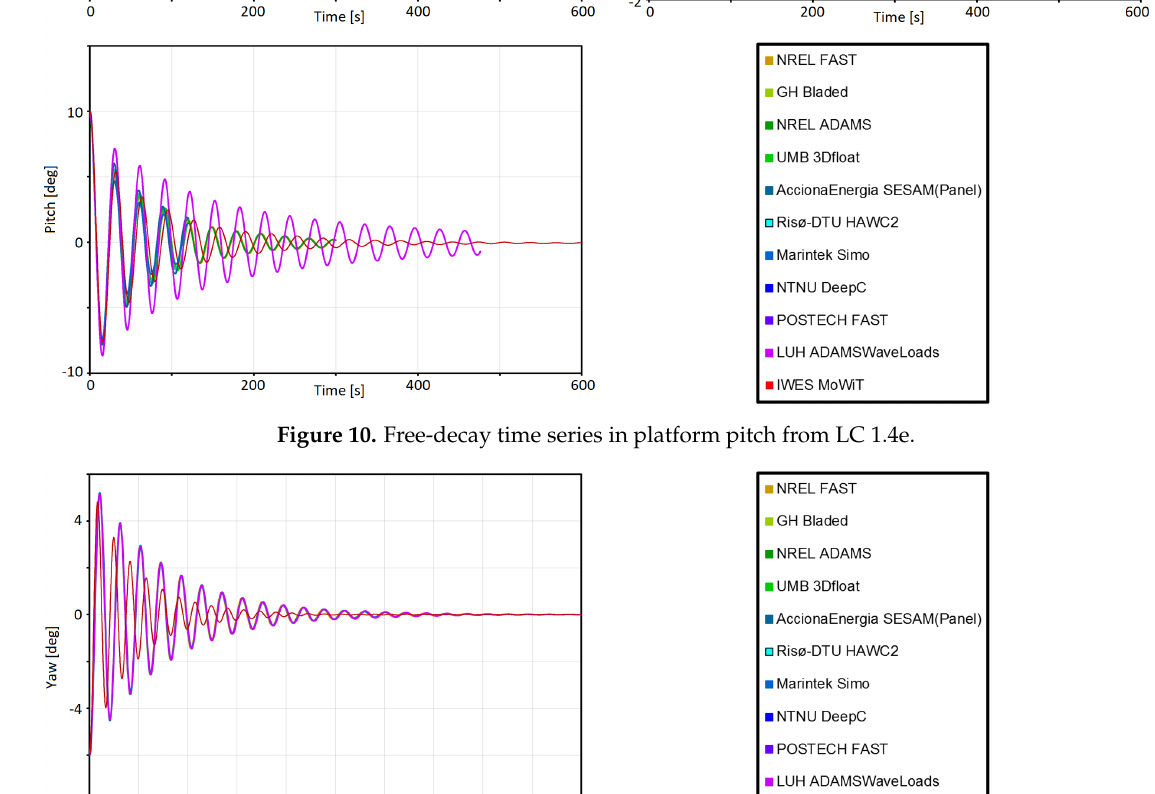
Figure 11. Free-decay time series in platform yaw from LC